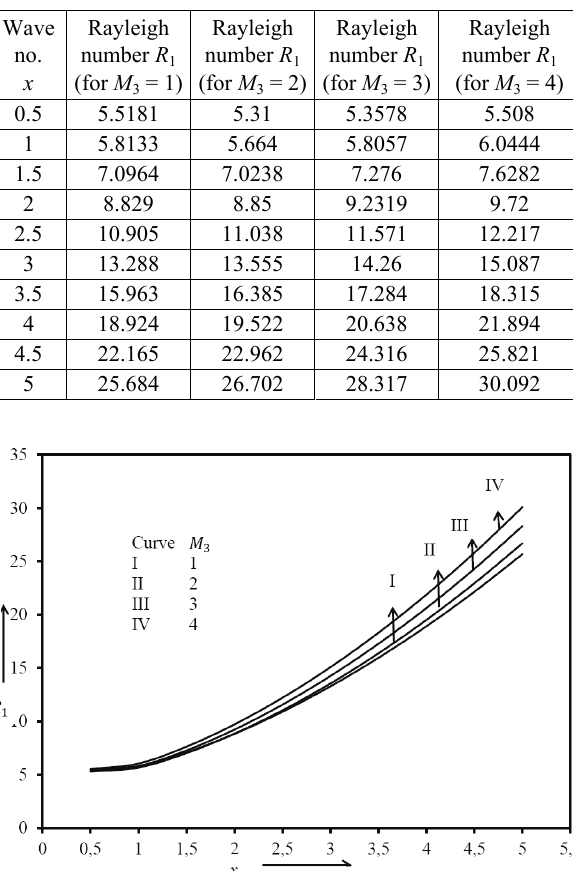
Table 2. Rayleigh numbers for M 3 = 1, 2, 3, 4